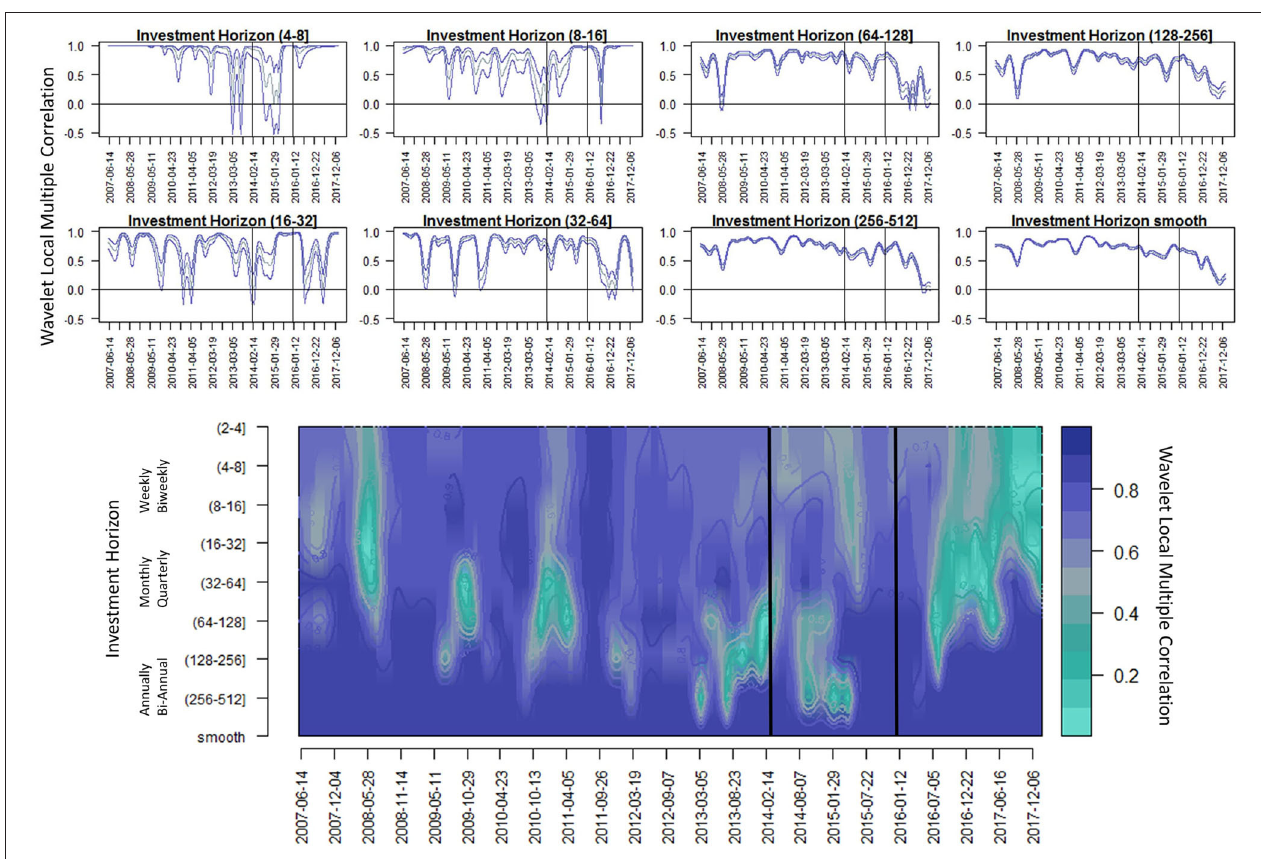
FIGURE 9 | The WLMC of the water-energy nexus and the S&P500. At the top the purple lines correspond to the upper and lower bounds of the 95% confidence interval for the WLMC statistic at four different investment horizons. On the bottom the heat plot corresponds to the single set of correlations for all three time series (XLE, CGW, and SPY) for each scale across time, the contour lines correspond to the confidence intervals depicted for the investment horizons at the